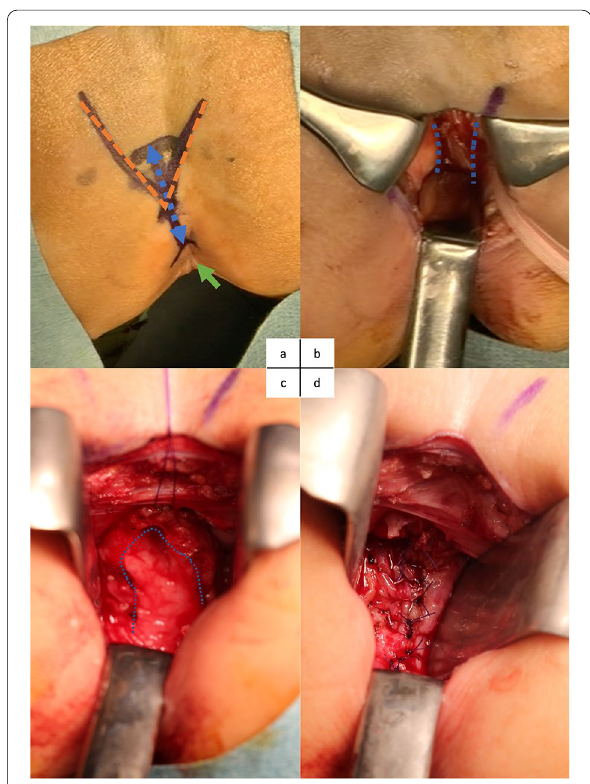
Fig. 6 Images of the posterior sagittal approach. a An incision (double arrow) is placed in the midline between the anus (single arrow) and coccyx (break line), deep into the layers to approach the rectum. b The rectum is taped and pushed aside to the right. The lateral wall of the vagina is lined with dots. c The anterior wall of the vagina is exposed after resection of the tumor. The dotted line indicates the edge of the vaginal wall. d Reconstruction of the